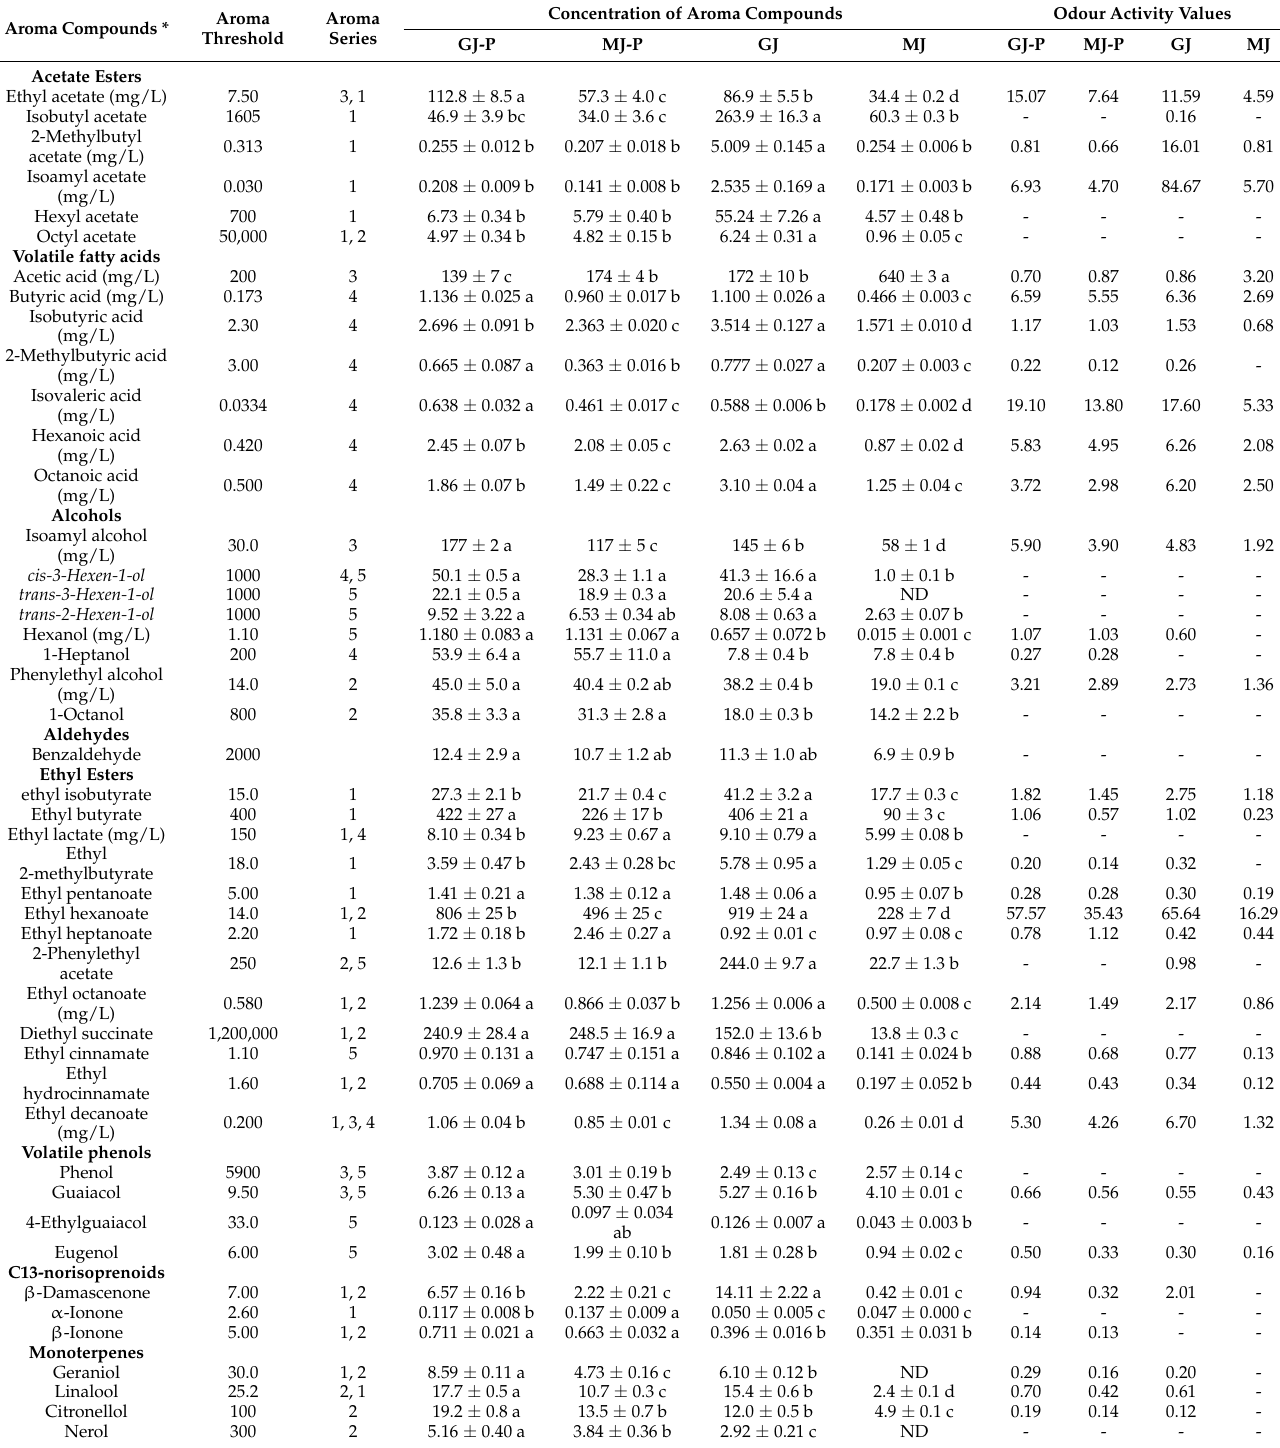
Table 4. Aroma compound concentrations and odour activity